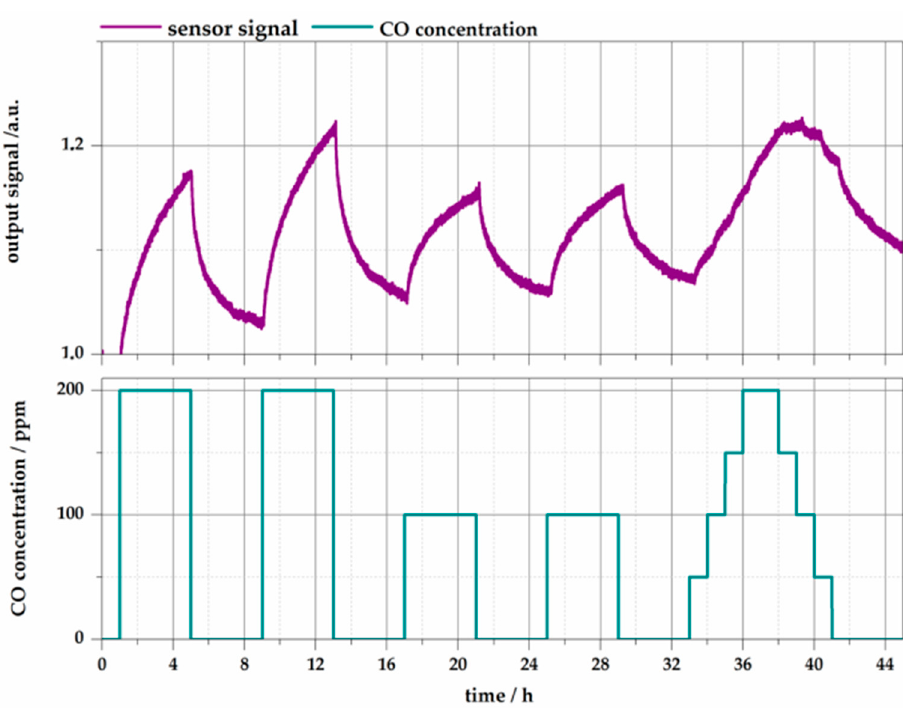
Figure 14. CO-dependent sensor reaction to 200 ppm and 100 ppm CO, as well as to different steps, recorded at room temperature with 40% r.H. The sensor shows sufficient repeatability over time. The measurement was performed using the sensor system shown in Figure 2b.